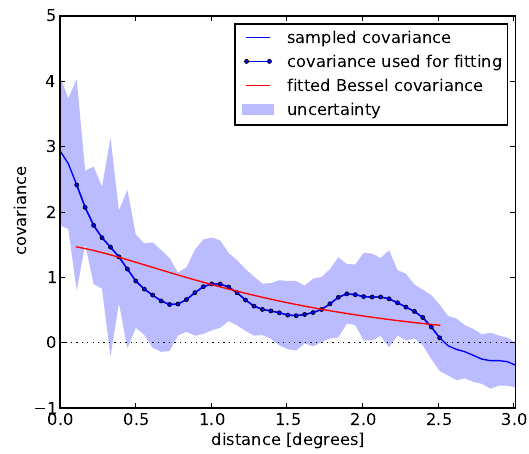
Fig. 4. Empirical covariance based on observations used to estimate correlation length and signal-to-noise